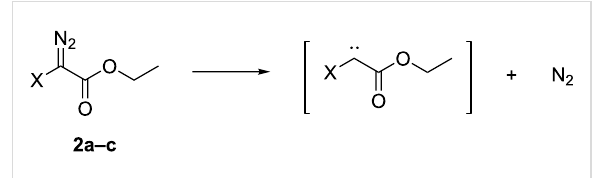
Scheme 2: Proposed rate determining step for the thermal decomposi- tion of 2a – c